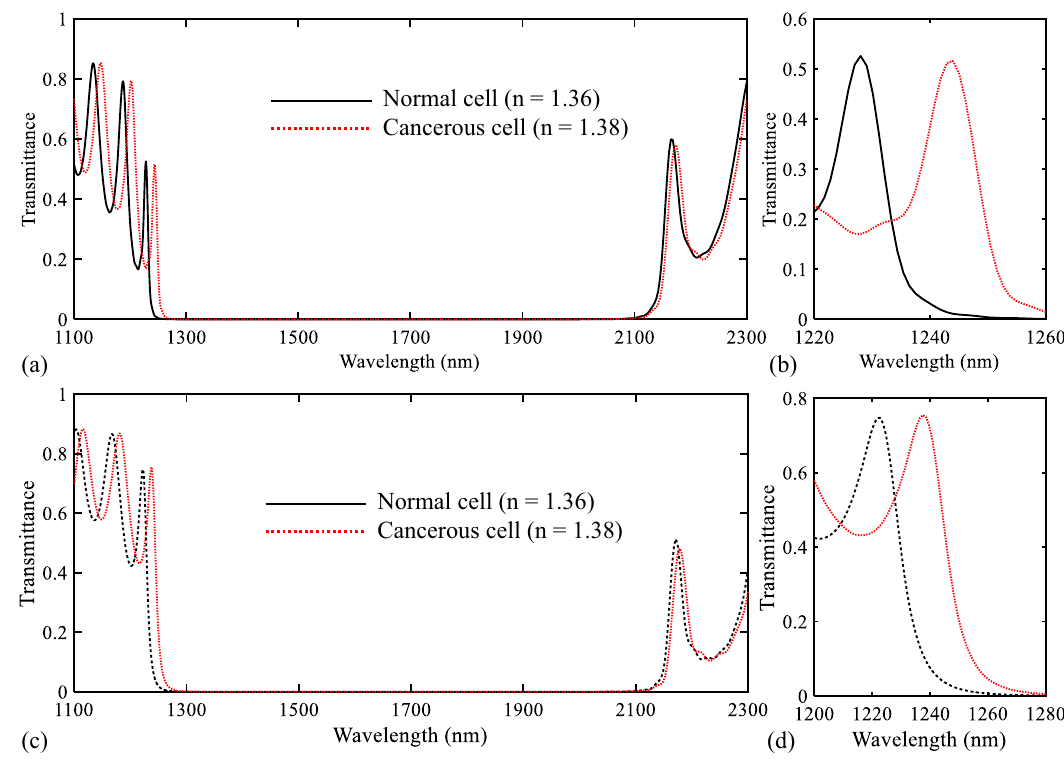
Figure 17. ( a , b ) Transmission spectra of the proposed biosensor I for normal (n = 1.36) and cancerous (n = 1.38) cells in different wavelength ranges. ( c , d ) Transmission spectra of the proposed biosensor II for normal (n = 1.36) and cancerous (n = 1.38) cells in different wavelength ranges.